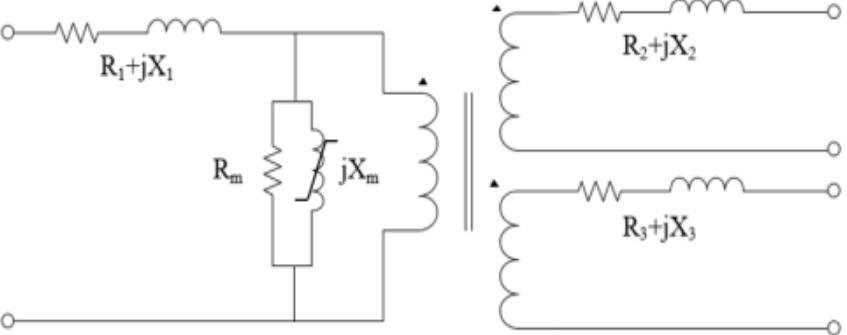
Figure 6. Main circuit structure of the high-speed EMU.